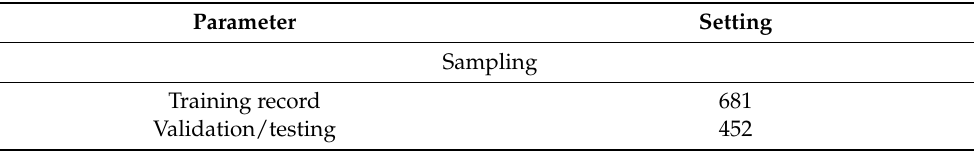
Table 3. Setting hyperparameters for the ANFIS